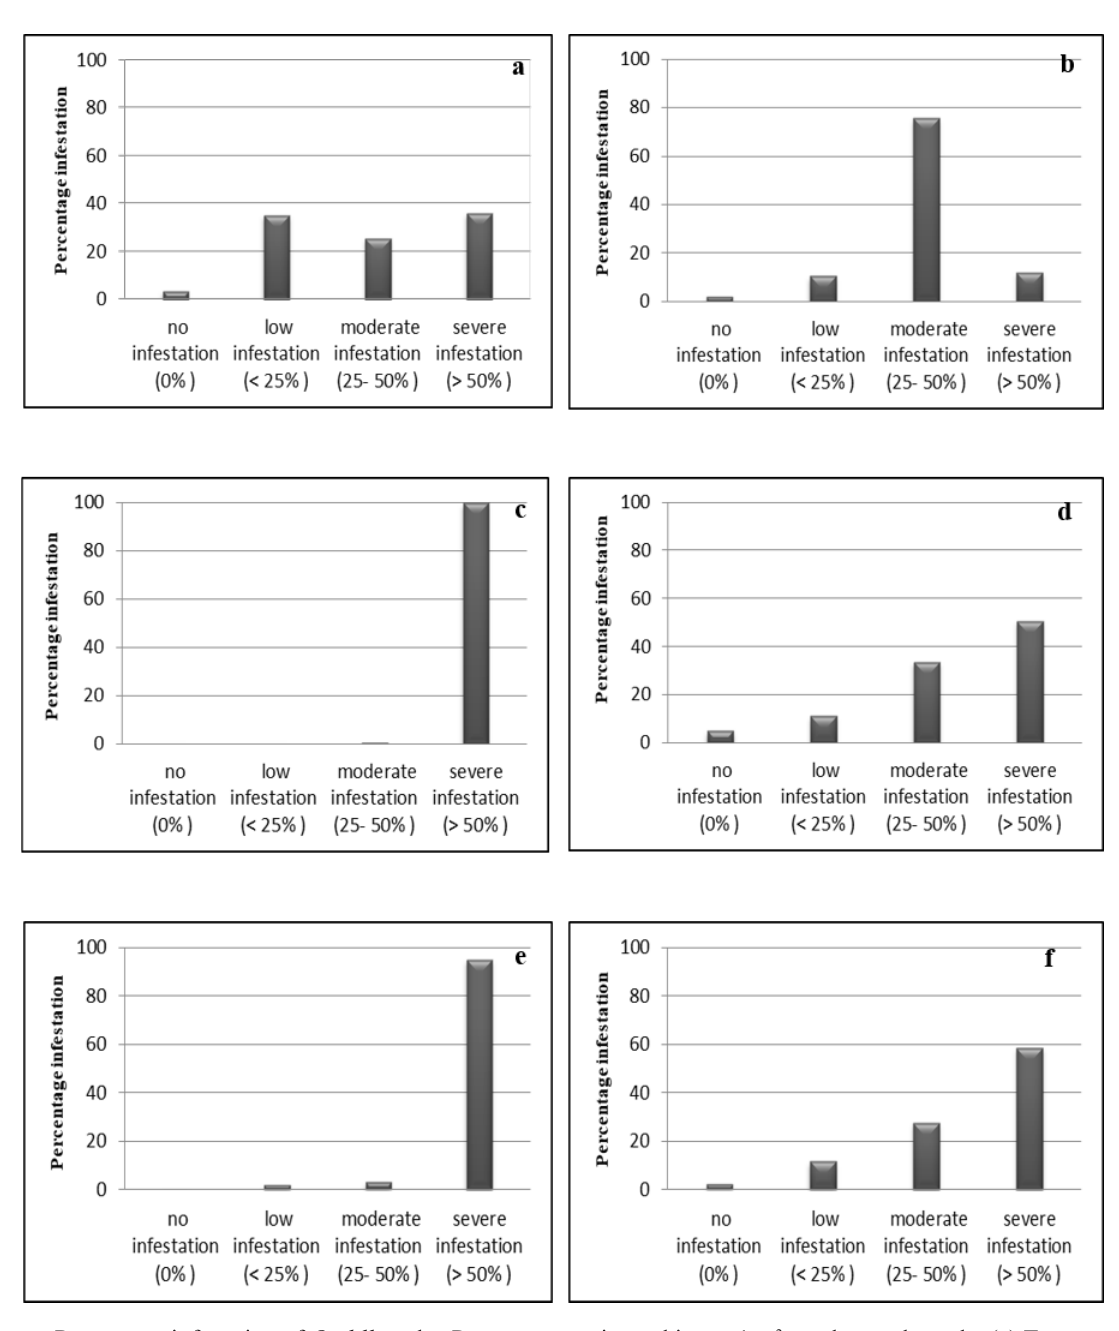
Figure 4: Percentage infestation of O. dillenii by D. opuntiae estimated in ten 1 m 2 quadrates along the (a) Transect 1, (b) Transect 2, (c) Transect 3, (d) Transect 4, (e) Transect 5, and (f) in the study area as a